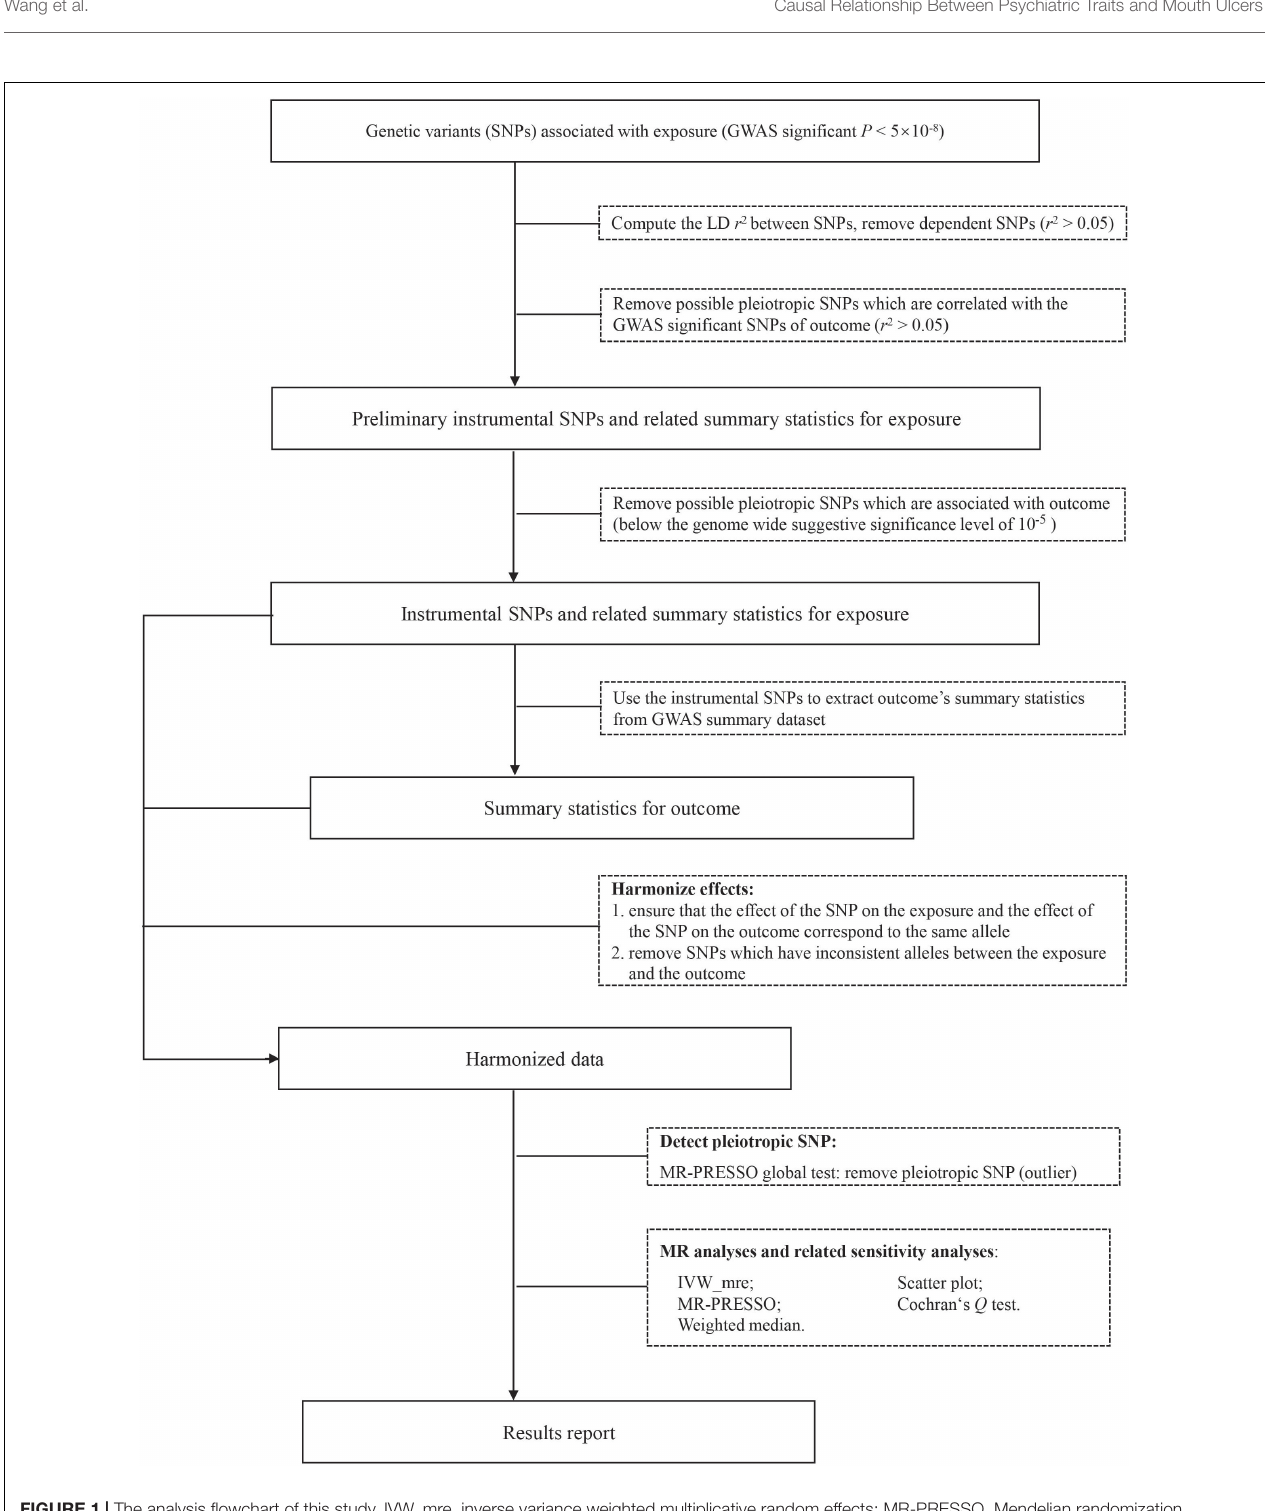
an outlier test to detect specific SNPs with horizontal